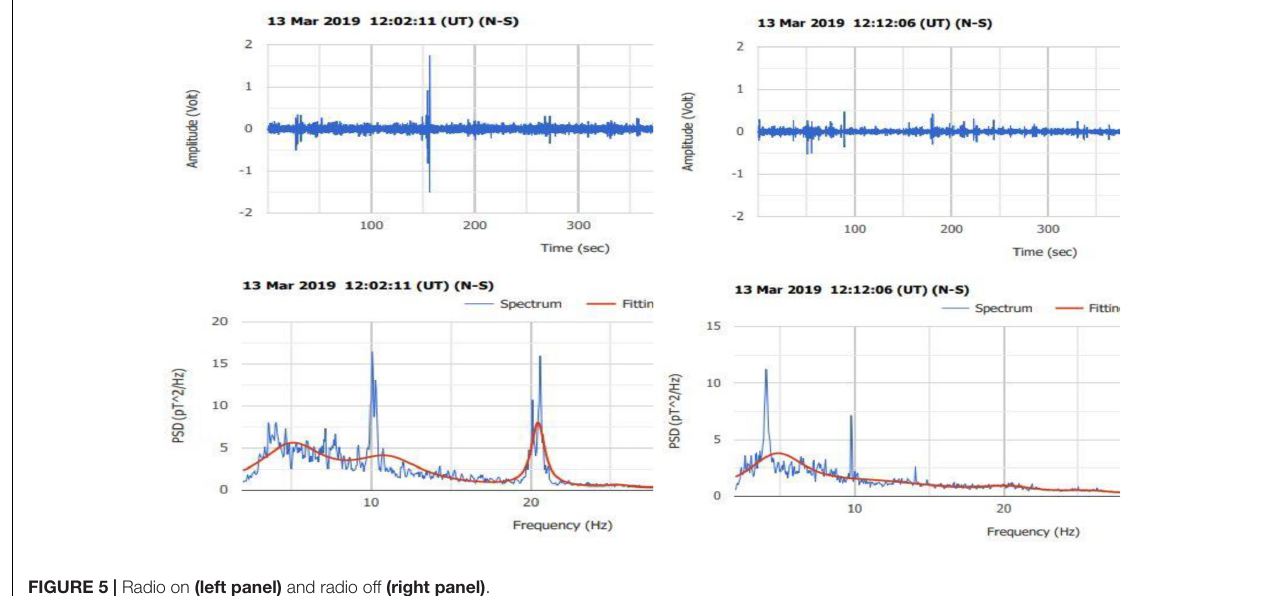
FIGURE 5 | Radio on (left panel) and radio off (right panel) .